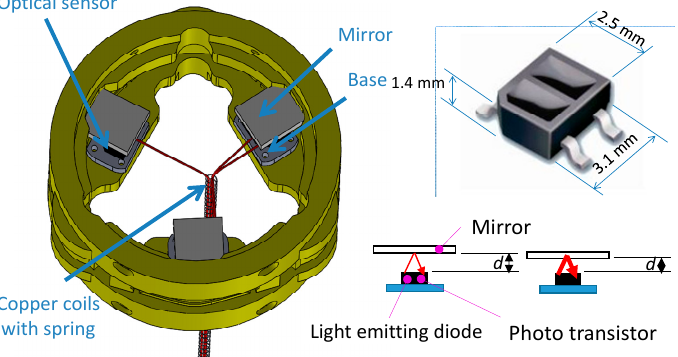
Figure 1. Assembly design for three axis force/torque sensor using three optoelectronic sensors and three mirrors, optoelectronic sensor, QRE1113, Fairchild Semiconductor Corp. (South Portland, ME, USA).